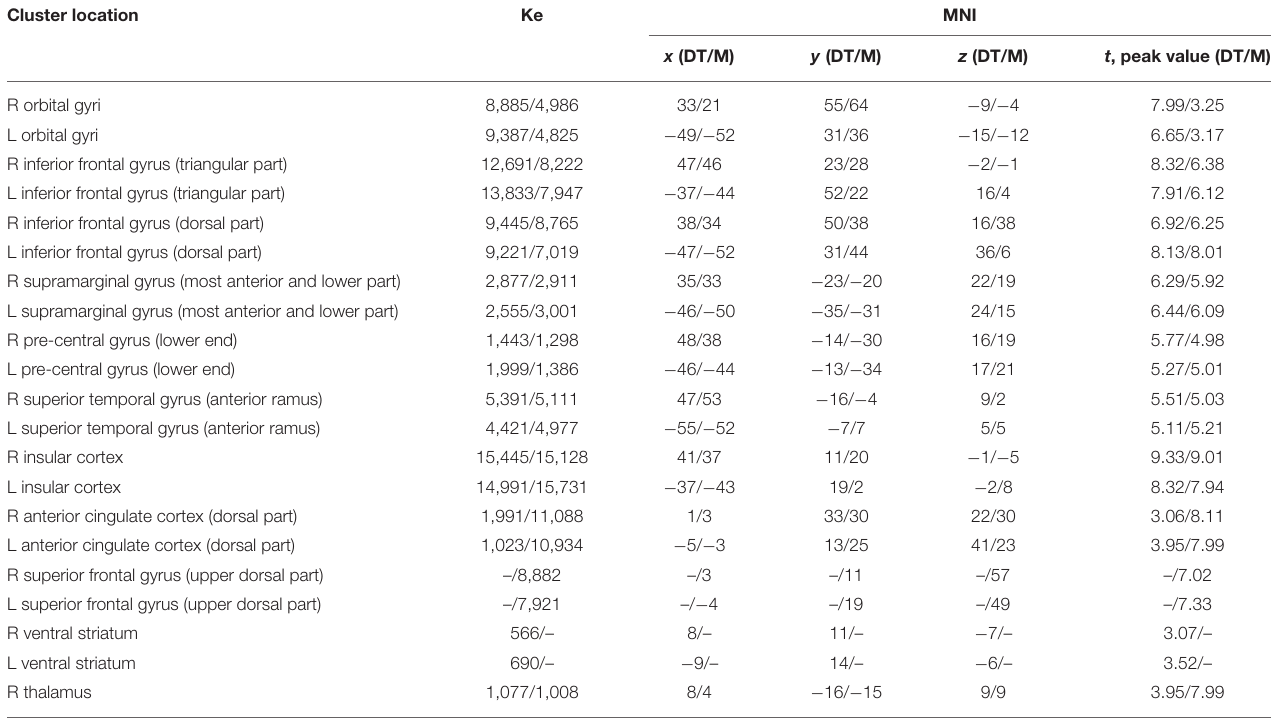
TABLE 3 | Spatial coordinates, extent, and peak values of brain areas showing significant GM density and metabolism changes between groups (bvFTD patients vs. cognitively unimpaired controls). Cluster